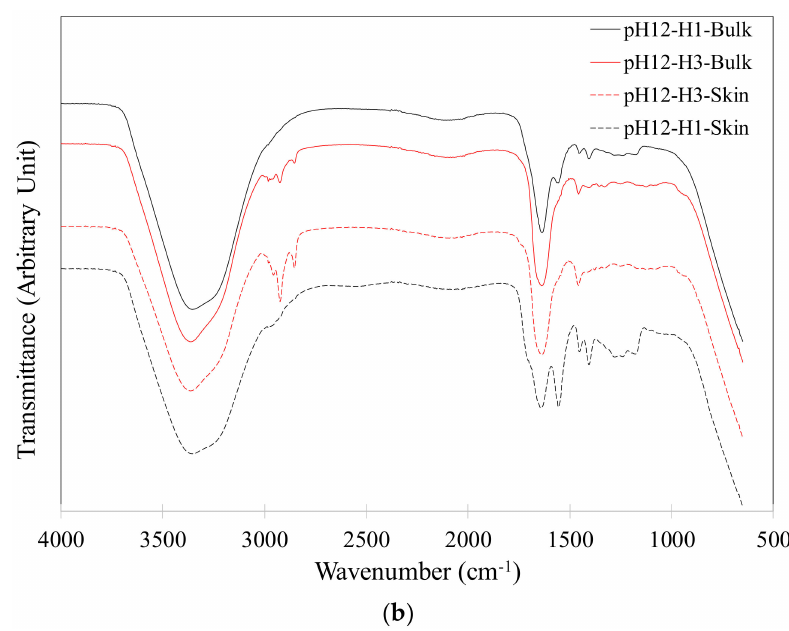
Figure 4. FTIR spectra of the skin and interior bulk of H-1 and H-3 after absorption in synthetic pore solutions with ( a ) pH = 13.7 and ( b ) pH =